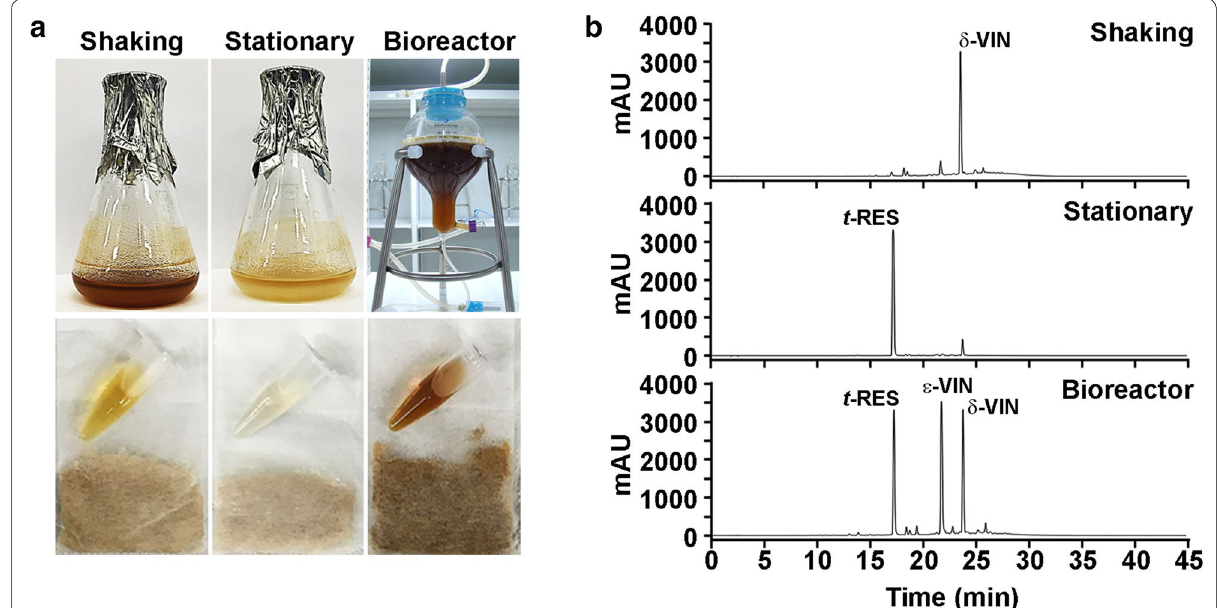
Fig. 5 Conditional production of trans ‑resveratrol, ε‑viniferin, and δ‑viniferin in grapevine cell culture medium under different culture conditions. a Phenotypes of grapevine cell cultures 5 days after co‑treatment with 100 µM MeJA and 50 mM STE in flask (shaking or stationary) and bioreactor cultures. b HPLC chromatograms (300 nm) of ethyl acetate extract from the culture medium of the elicited cell cultures showing production of resveratrol and viniferin in flask and bioreactor cultures. For flask and bioreactor cultures of grapevine cells, cells were pre‑cultured for 7 or 14 days in 500‑mL Erlenmeyer flask and in a 3‑L bioreactor, respectively, and harvested 5 days after co‑treatment with 100 µM MeJA and 50 mM